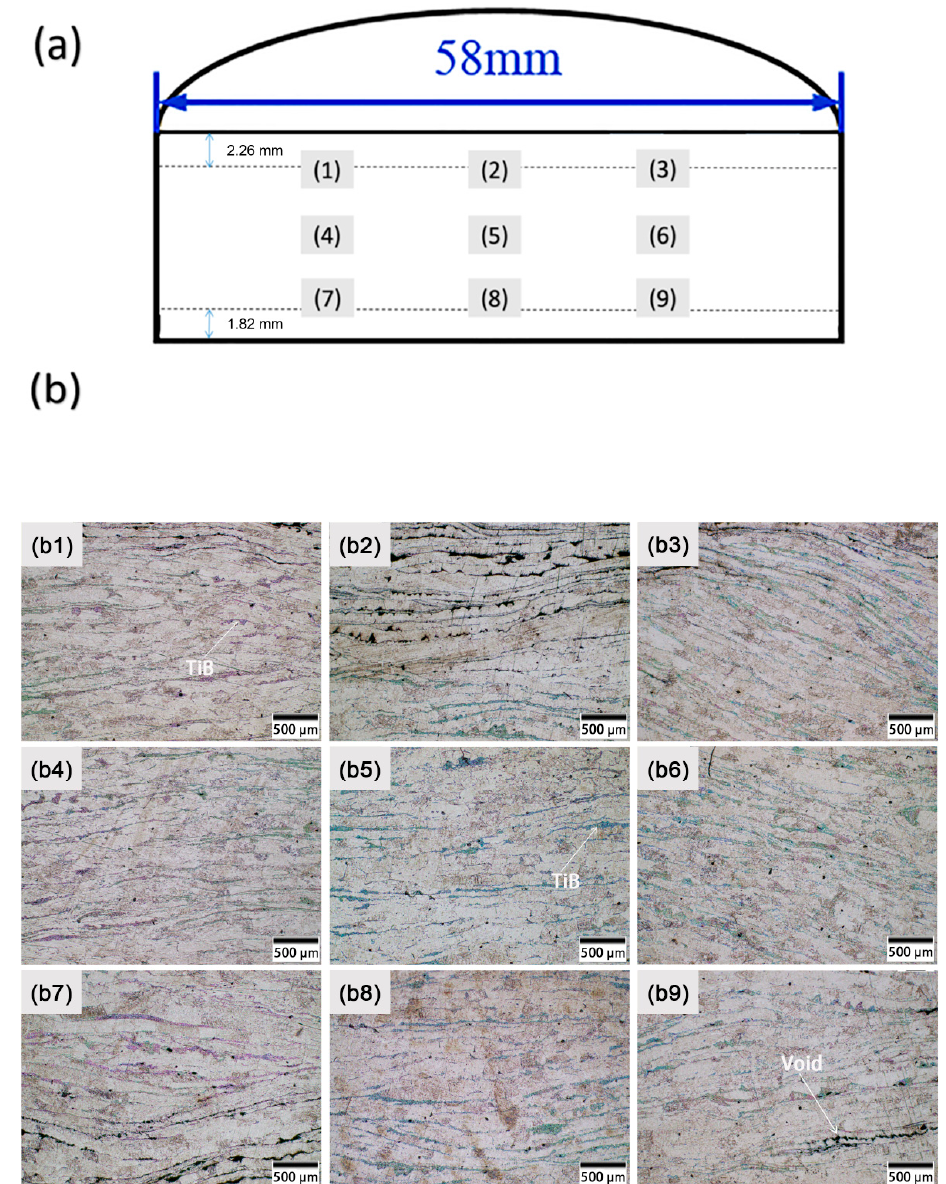
Figure 6. ( a ) Schematic drawing of the cross section of the Chips-Ti64-5TiB showing the locations where the microstructures of the material were examined; and ( b ) the optical microstructures of the Chips-Ti64-5TiB composite at nine different points (( b1 ) is the position of 1 in ( a ), ( b2 ) is the position of 2 in ( a ), and so on with ( b3 – b9 .).